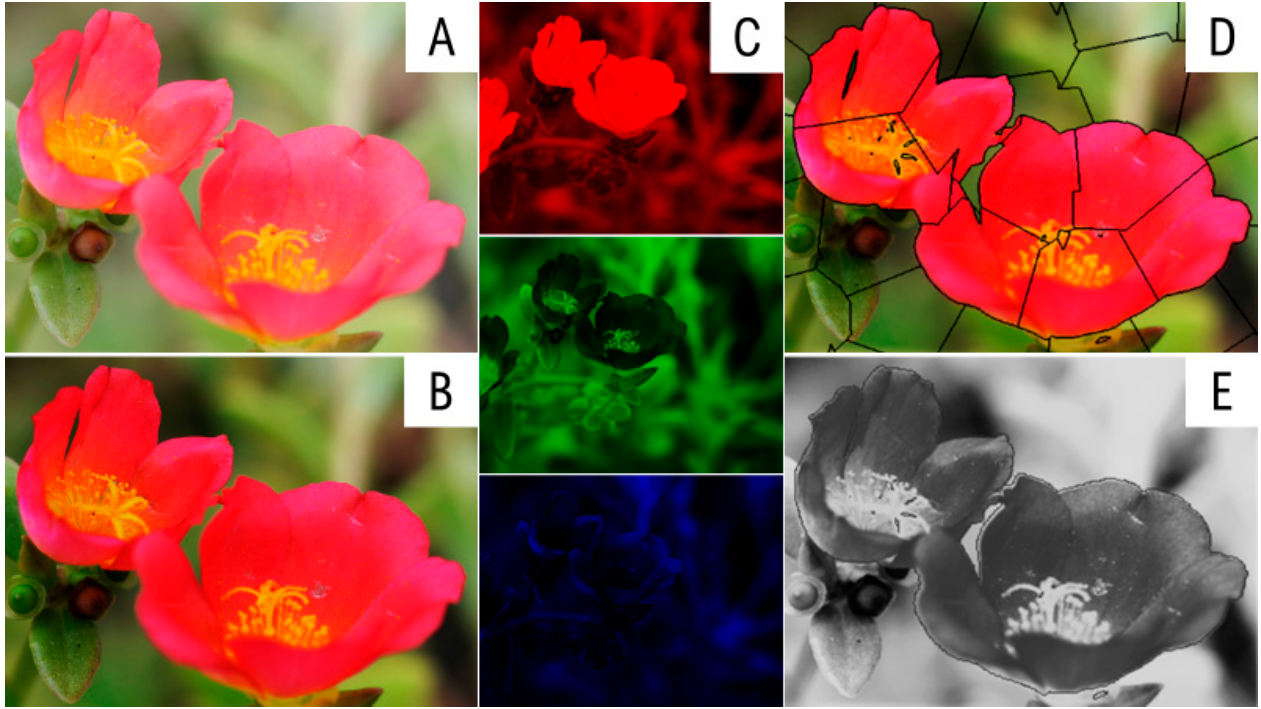
Figure 6. Major steps of the processing of the image in predicting the pixel-wise intensity of the flower’s color upon the fractality of architecture of P. umbraticola ; labeling ( A ), equalization ( B ), quantization ( C ), segmentation ( D ), and binarization ( E ).